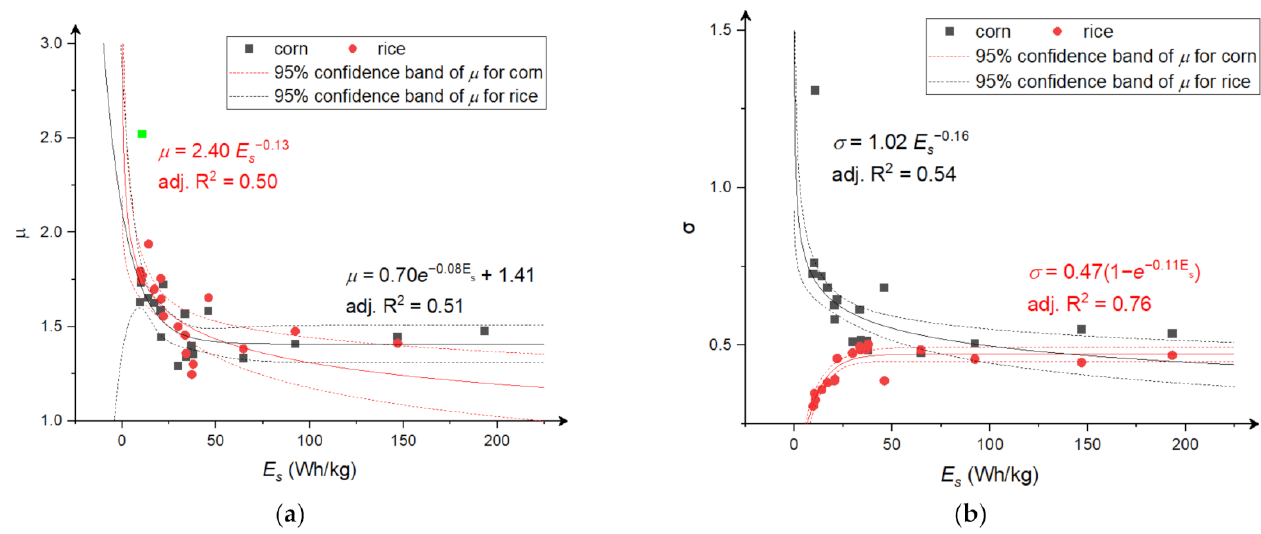
Figure A3. The dependence between µ (average value) and σ (variance) and specific comminu- tion energy; ( a ) µ (average value); ( b ) σ (variance). The green points are outliers not included in the